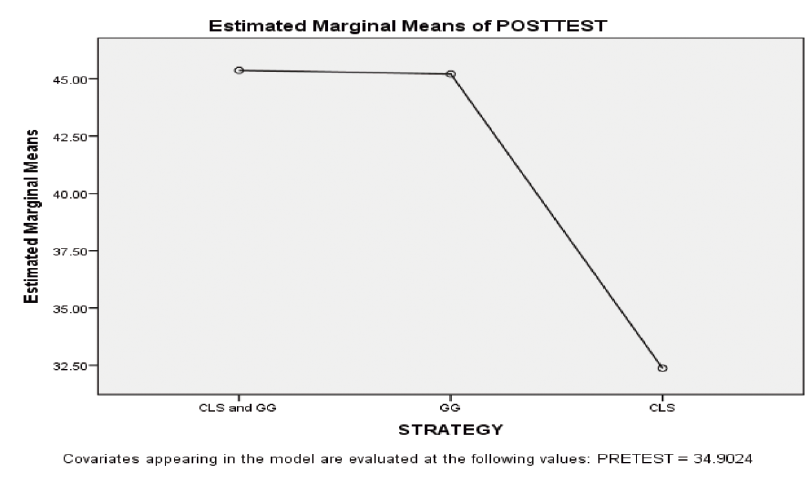
Figure 6. Post-test estimated marginal